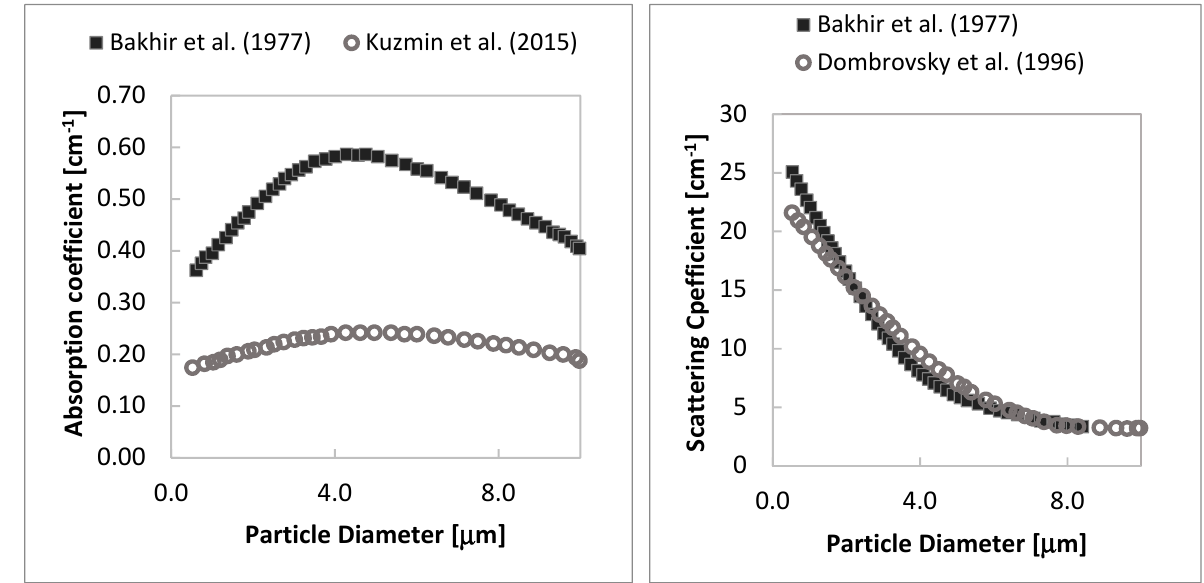
Figure 2. Absorption coefficient (on the left) and scattering coefficient (on the right) for different alumina particle diameters. Reprinted with permission from [10,11,15].